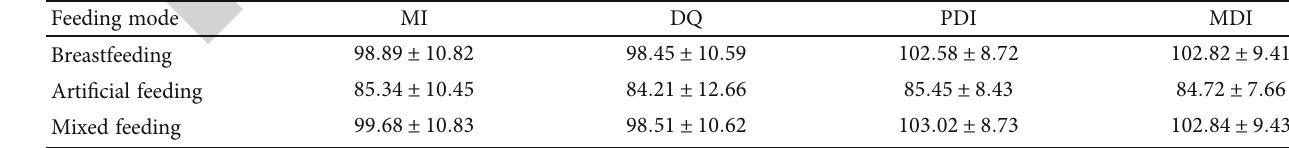
Figure 4: Trend of obesity rate in di ff erent feeding methods. Table 4: Analysis of DST and BSID test results of infants with di ff erent feeding